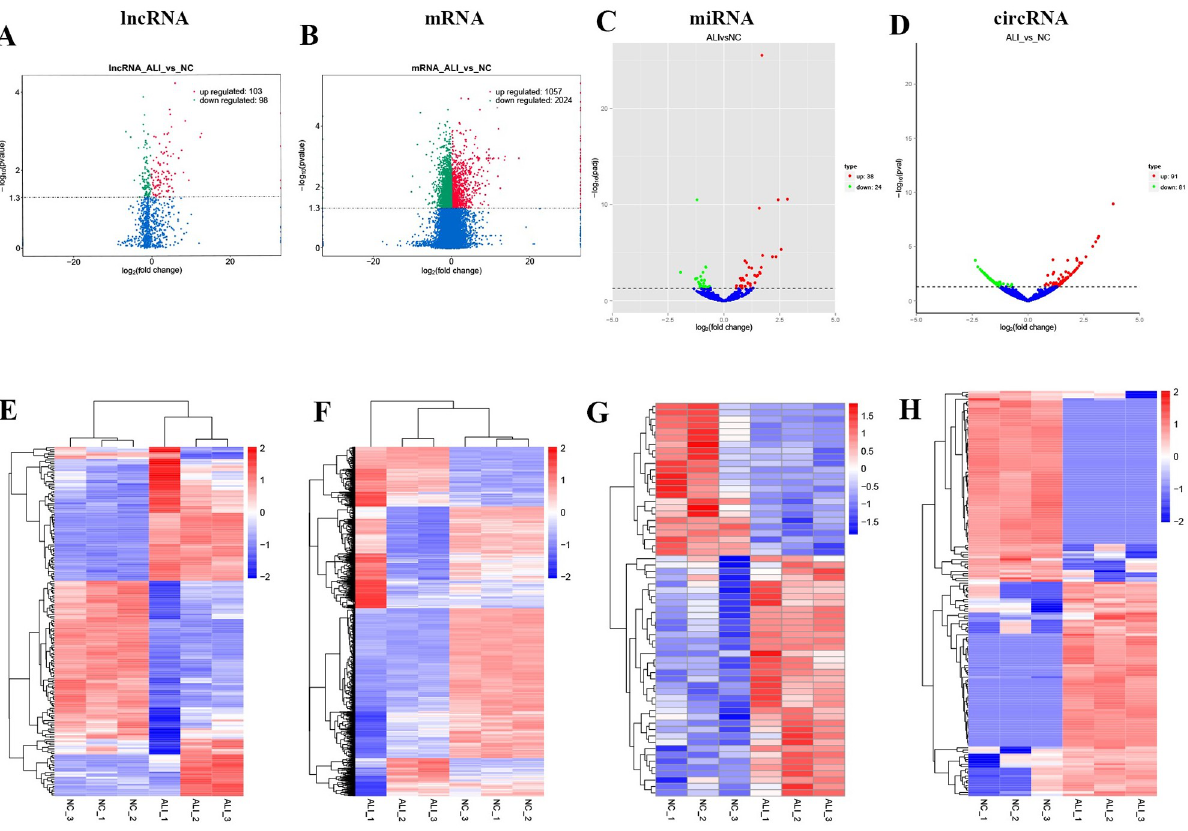
Fig 3. Identification of DE lncRNAs, DE mRNAs, DE circRNAs, DE miRNAs in ALI mouse model. (A)-(D) The volcano plots of DE lncRNAs, DE mRNAs, DE circRNAs, DE miRNAs in ALI mouse model. (E)-(H) The heatmap of DE lncRNAs, DE mRNAs, DE circRNAs, DE miRNAs in ALI mouse